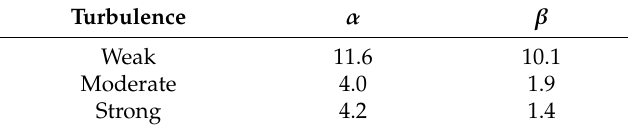
Table 1. Parameters for di ff erent turbulence